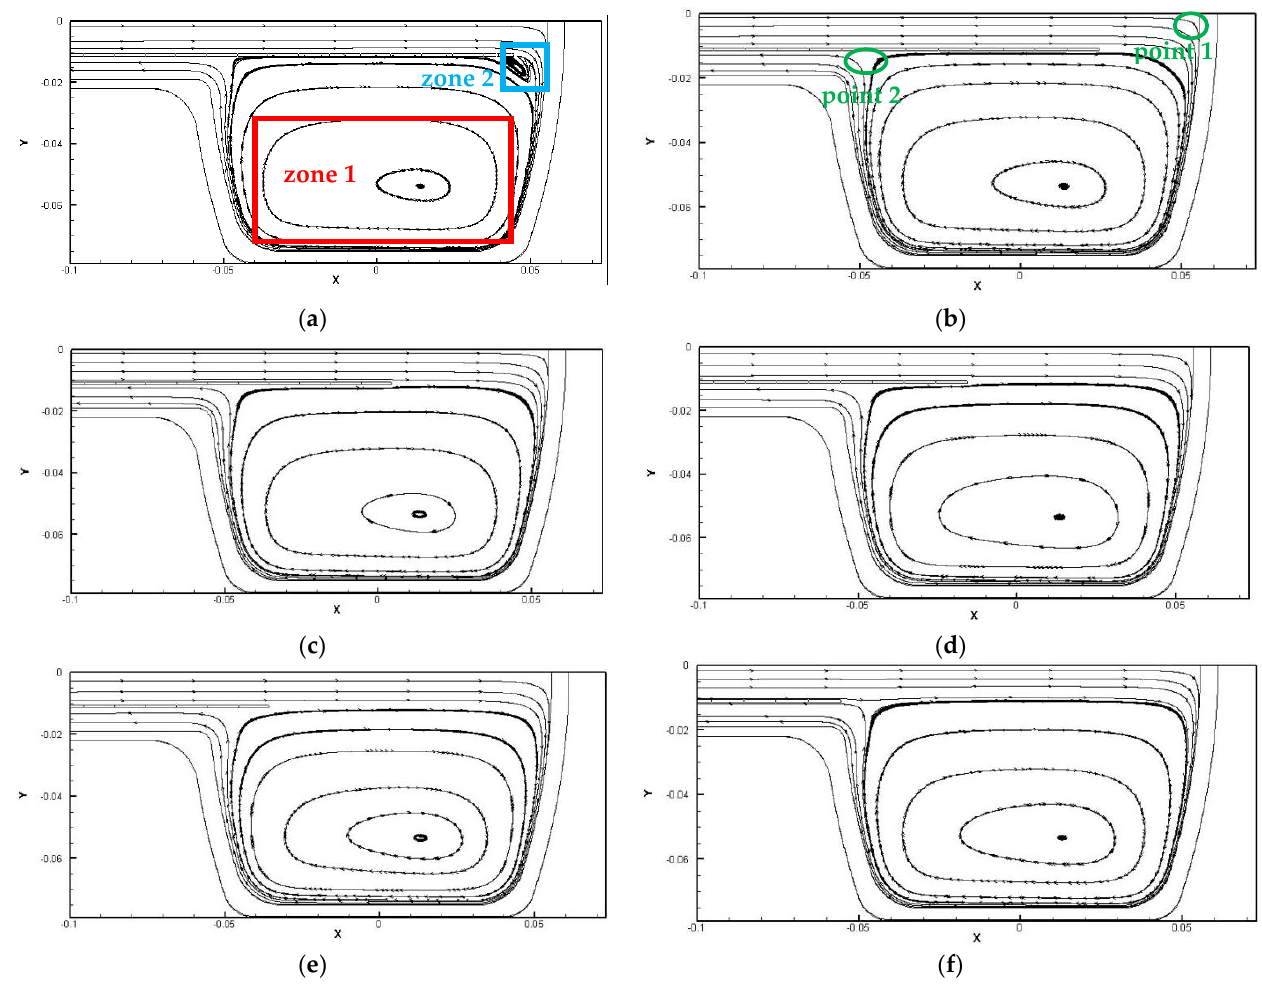
Figure 8. Streamline profile of CHM: ( a ) H/D = 0.5; ( b ) H/D = 1.5; ( c ) H/D = 2.5; ( d ) H/D = 3.5; ( e ) H/D = 4.5; ( f ) H/D = 5.5.